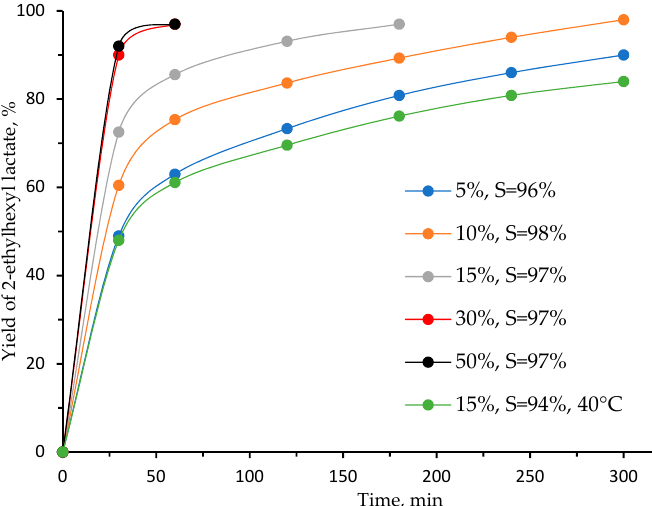
Figure 1. The influence of catalyst loading on the yield of 2-ethylhexyl lactate.